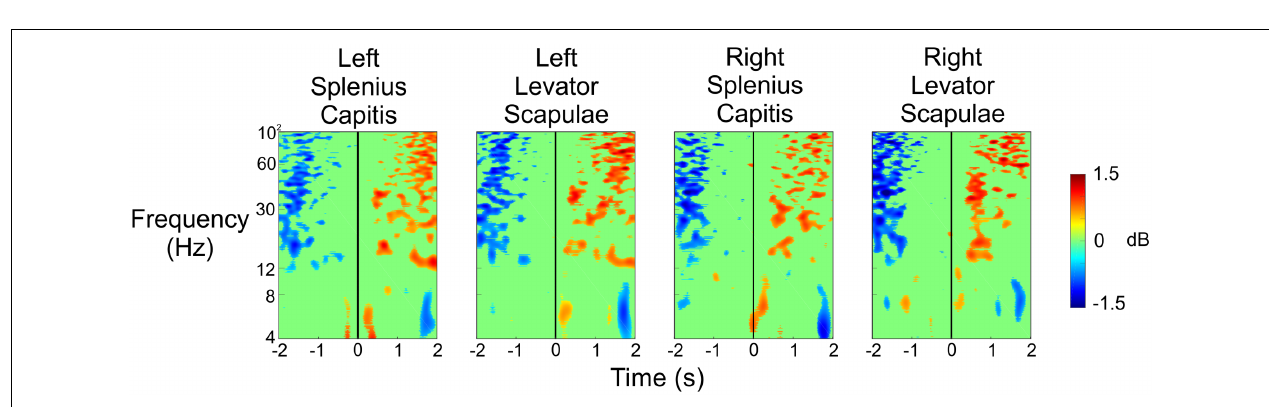
FIGURE 7 | Event-related spectral perturbation plots for the neck muscle activity during the Stress and Control conditions, as well as the difference of the two conditions. The vertical black line indicates the time the subject pulled the trigger.